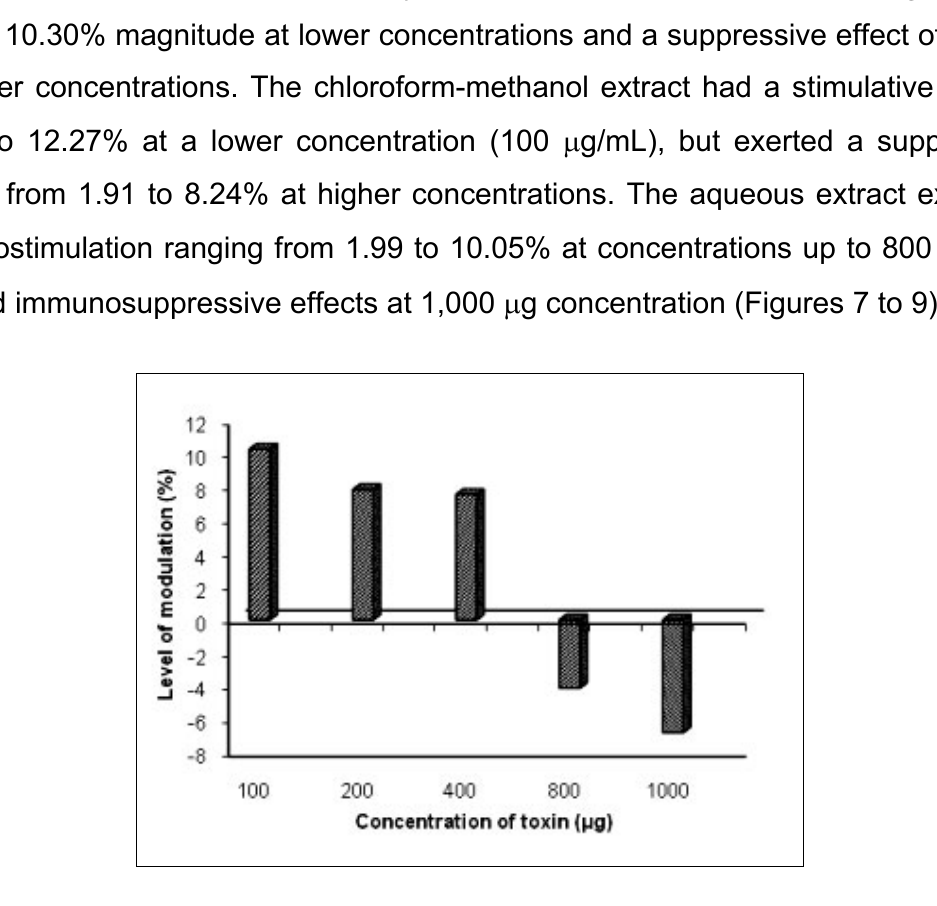
Figure 7. Immunomodulation produced by the methanolic extract of Halichondria panicea .